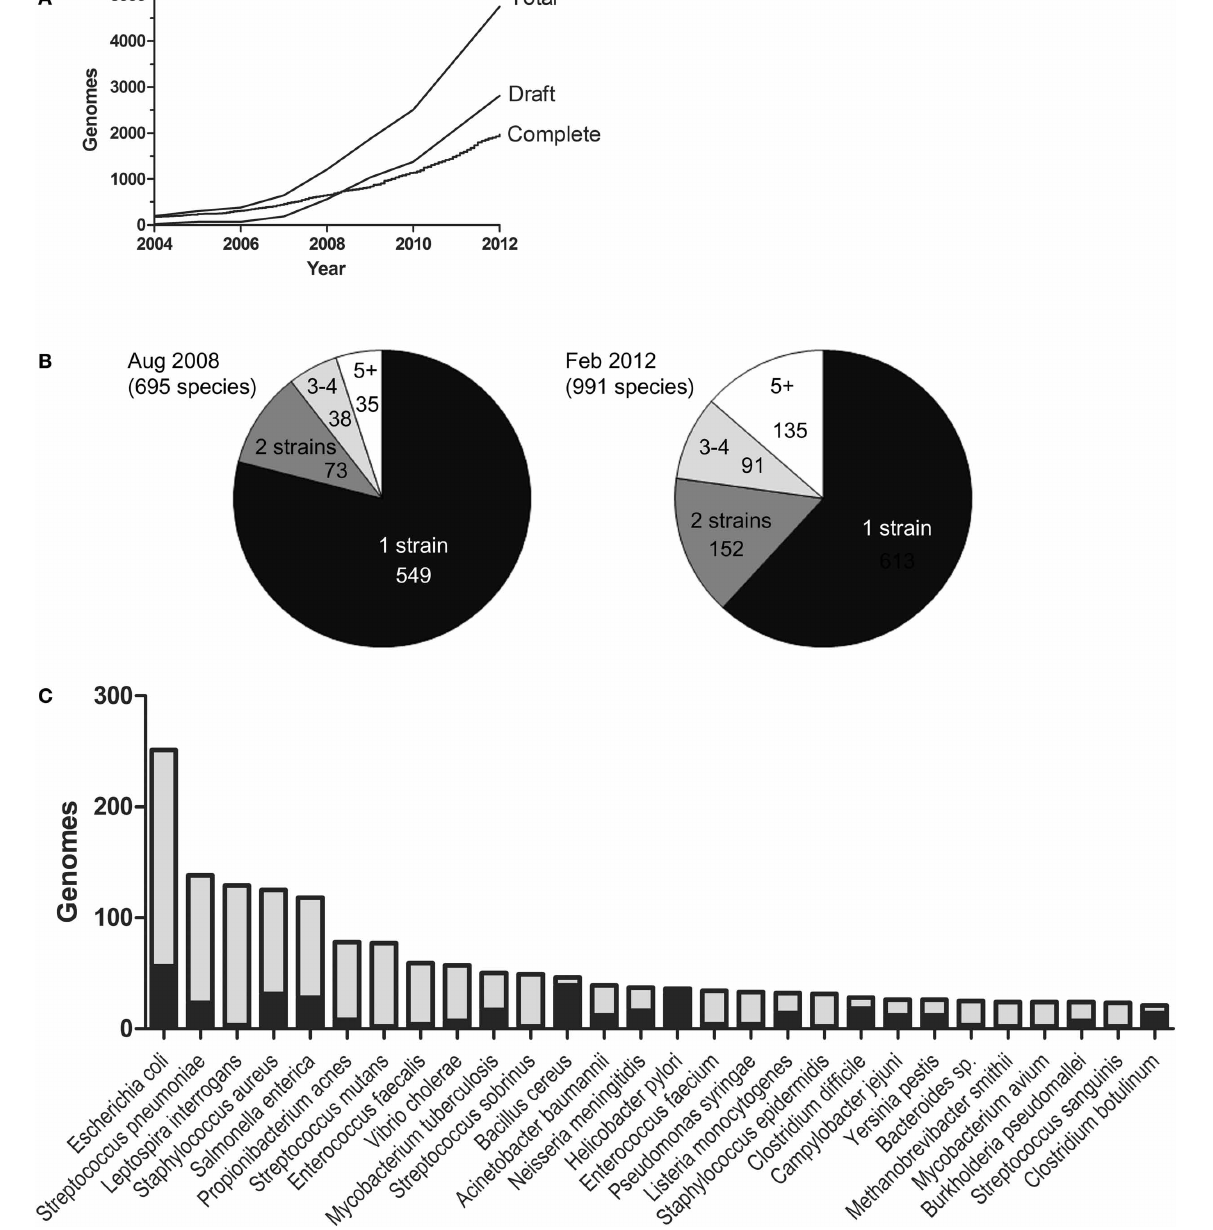
genomes. (B) The number of species with 1, 2, 3, 4, and 5 (or more) strains sequenced Aug 2008 and Feb. 2012, respectively. (C) The species with most genome sequences. Black represents completed genomes and grey draft